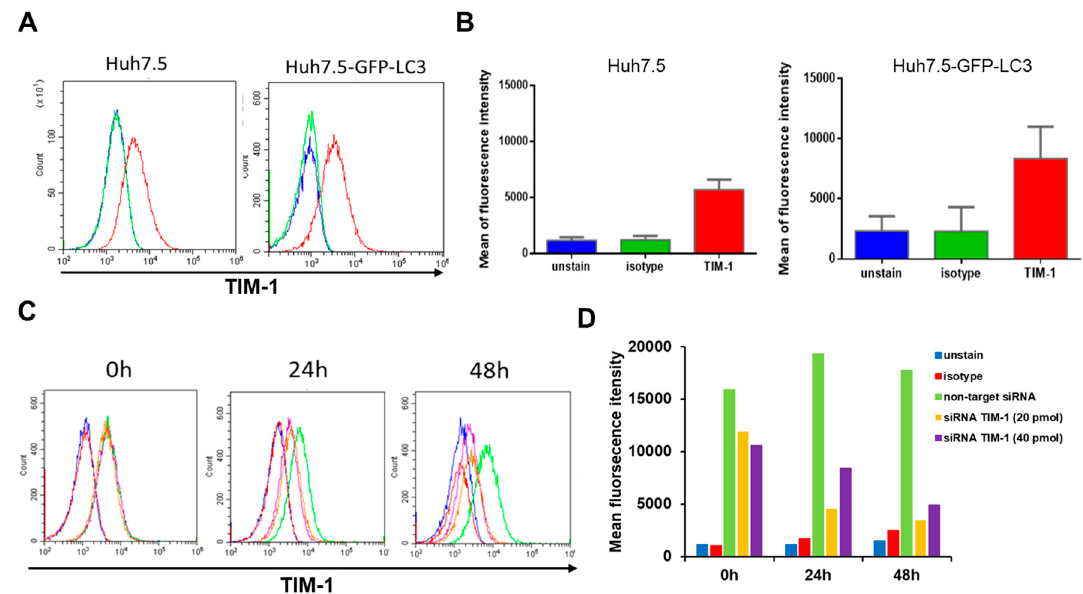
Figure 1. The expression of T-cell / transmembrane immunoglobulin and mucin domain protein-1 (TIM-1) and the treatment of siRNA against TIM-1 in Huh7.5 and GFP-microtubule-associated protein light chain 3 (LC3)-Huh7.5 cells. ( A ) TIM-1 expressed on the surface of Huh7.5 and GFP-LC3-Huh7.5 cells (red line). The green line represents cell staining with a control antibody and the blue line represents unstained cells. ( B ) The quantification of the histogram depicted the mean fluorescence intensity of each group from ( A ). ( C ) We confirmed by flow cytometry the reduced expression of TIM-1 after using specific siRNA (si-TIM-1). Representative experiments of the transfection of GFP-LC3-Huh7.5 with non-targeting siRNA (blue) and si-TIM1 with 20 pmol (orange) and 40 pmol (purple) were displayed, respectively. Two additional control groups, including unstained and isotype, were marked in blue and red. ( D ) The quantification of the histogram presented the mean fluorescence intensity of each group from ( C ).